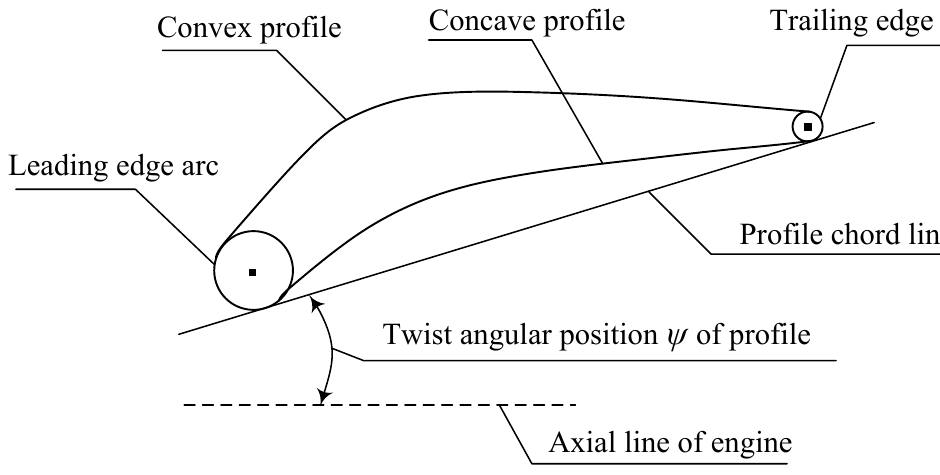
Figure 1. Definition diagram of the twist angular position of profile.